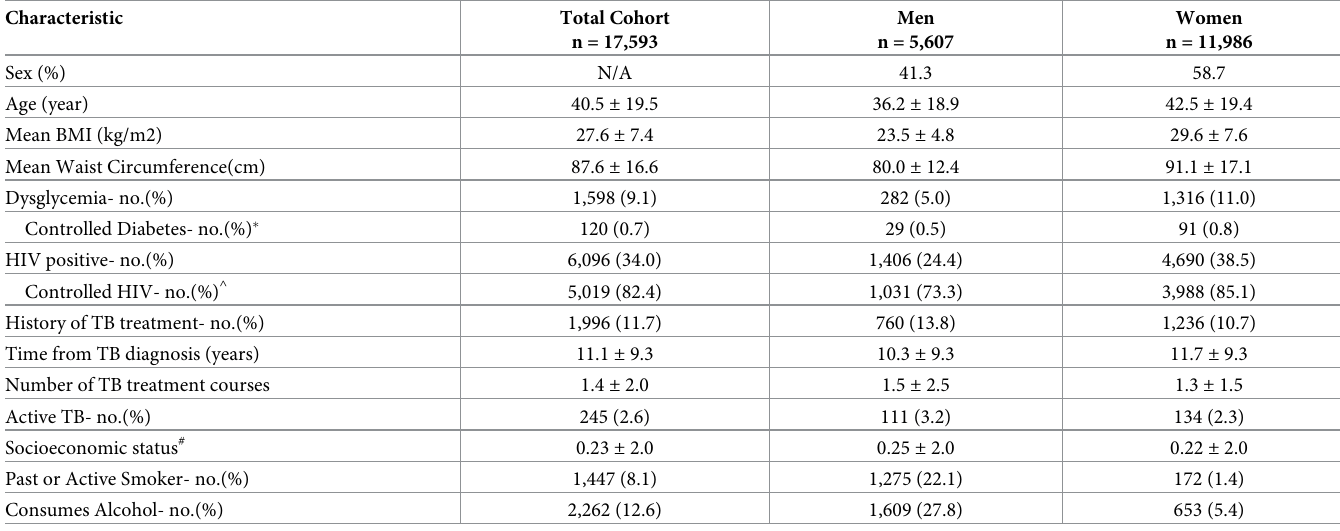
Table 1. Unweighted baseline characteristics of